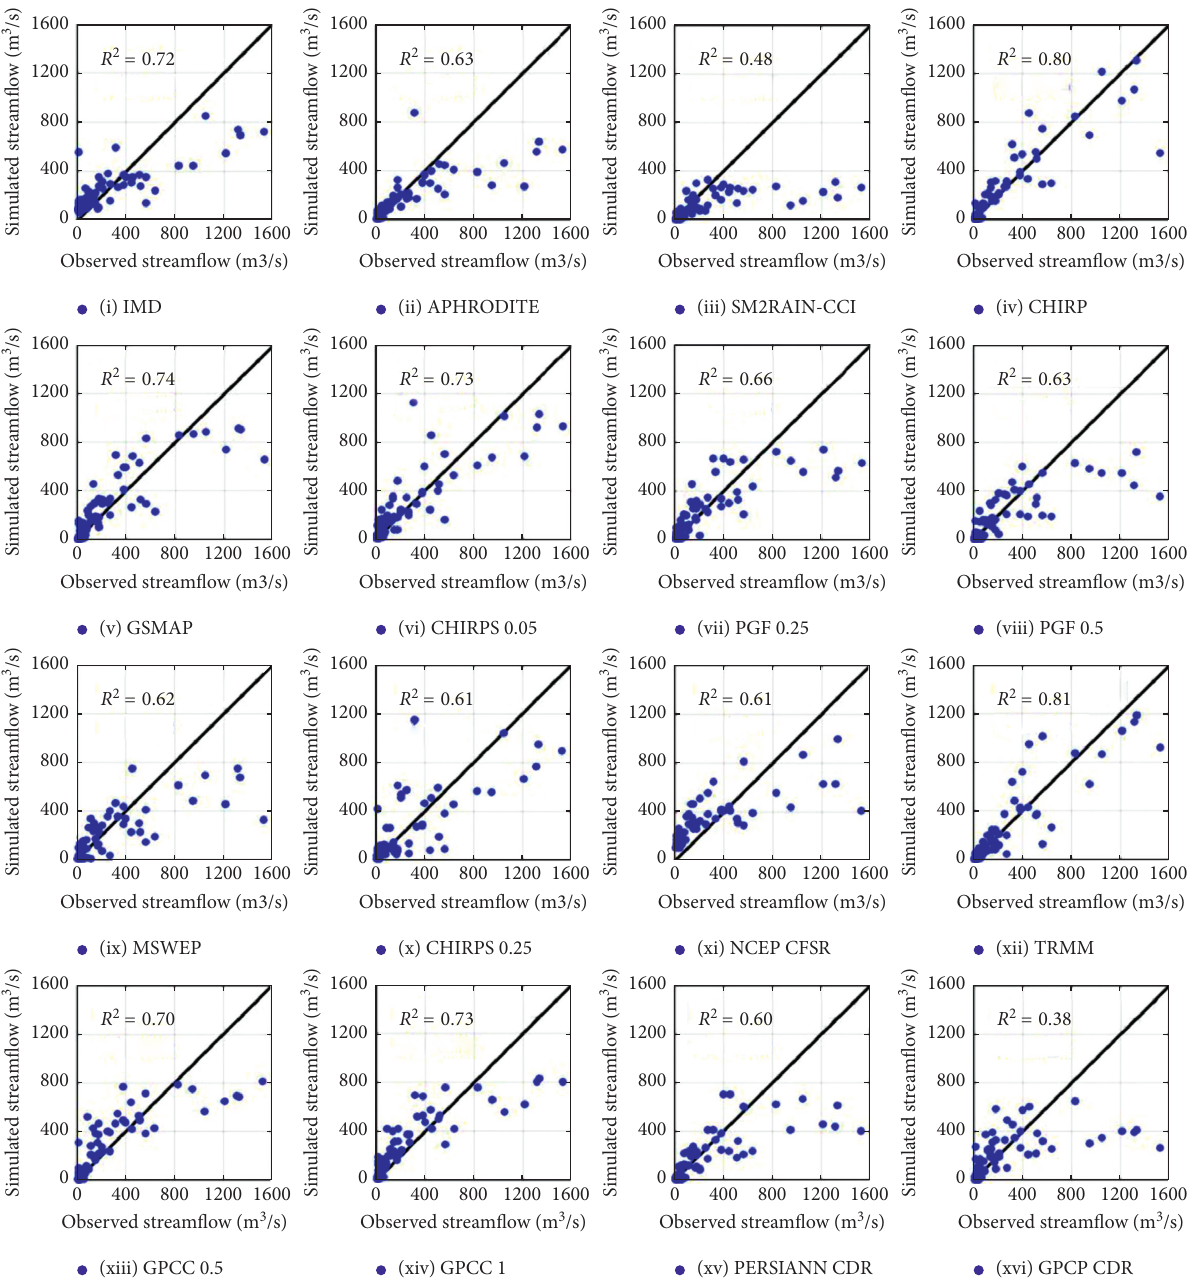
Figure 7: Scatterplots depicted for simulated versus observed runoff for (a) IMD, (b) APHRODITE, (c) SM2RAIN-CCI, (d) CHIRP, (e) GSMaP_Gauge_RNL v6, (f) CHIRPS 0.05 ° , (g) PGF 0.25 ° , (h) PGF 0.5 ° , (i) MSWEP, (j) CHIRPS 0.25 ° , (k) NCEP CFSR, (l) TRMM 3B42 v7, (m) GPCC v7, (n) GPCC v2018, (o) PERSIANN-CDR, and (p) GPCP-CDR v1.3 rainfall datasets during calibration